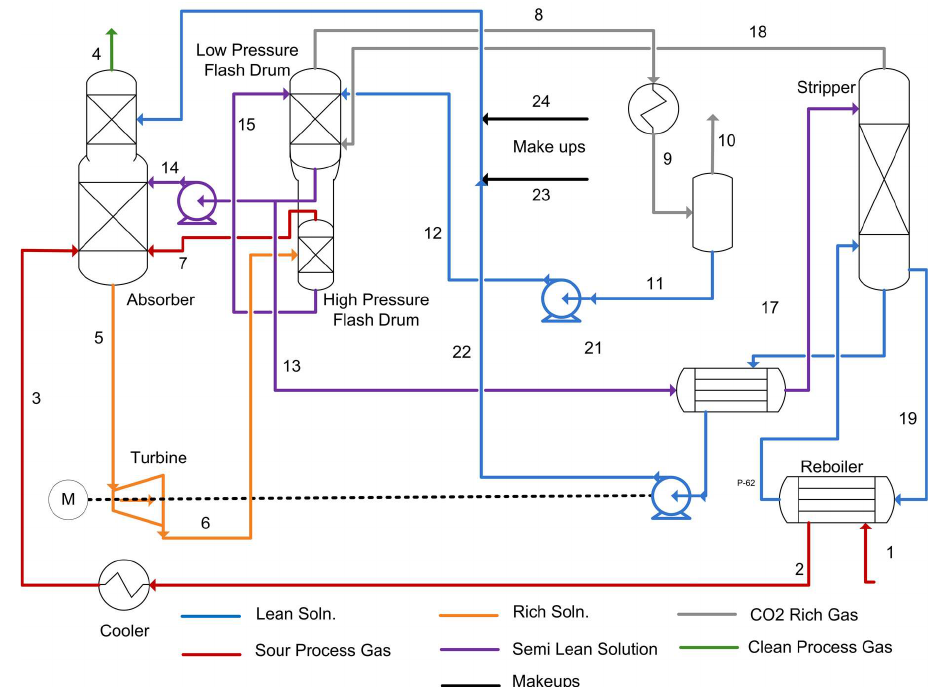
Figure 8. Process description of CO 2 absorption facility in an ammonia-manufacturing unit from natural gas.